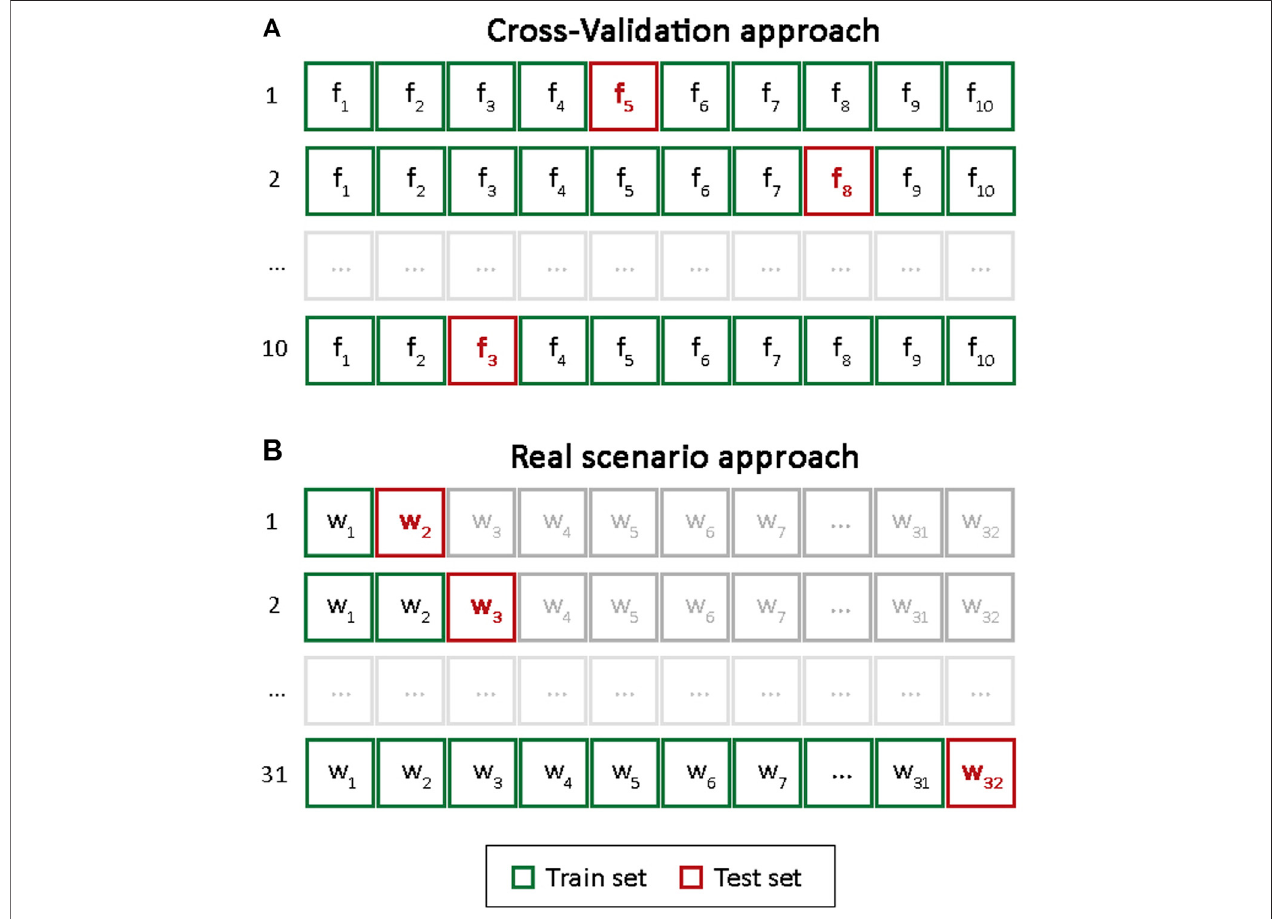
FIGURE 1 | Model validation approaches. f and w refer to fold and week, respectively. (A) Cross-Validation approach. (B) Real scenario approach.